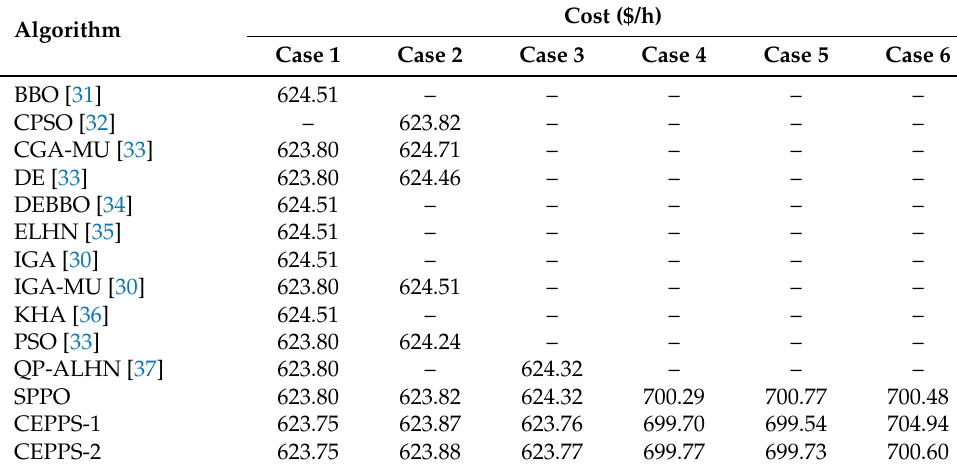
Table 3. Test Power System 1, comparison of economic load dispatch (ELD) ( P D = 2700 MW). BBO, biogeography based optimization; DE, differential evolution; ELHN, enhanced augmented Hopfield neural network; IGA, improved gravitational search algorithm; KHA, krill herd optimization; QP- ALHN, quadratic programming augmented Hopfield neural